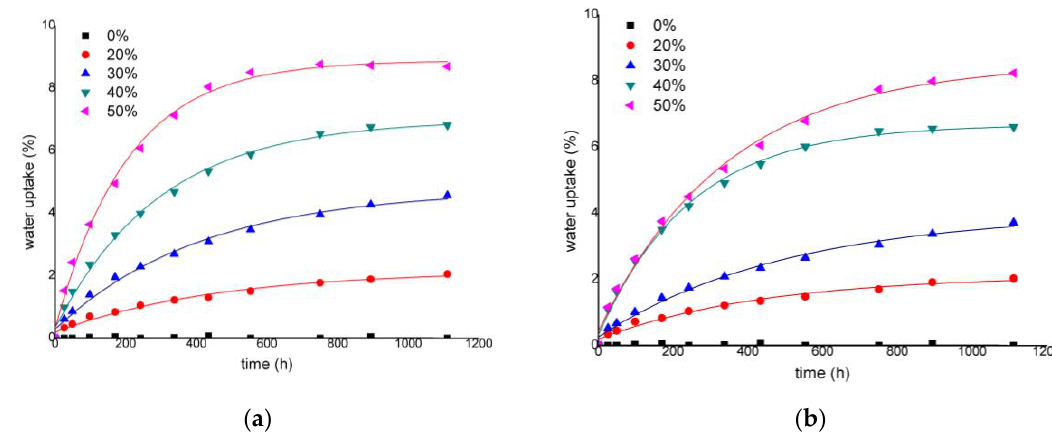
Figure 7. Water uptake profiles of composites reinforced with different percentages of ONPF under water immersion conditions: ( a ) Uncoupled ONPF composites; ( b ) Coupled ONPF composites. 353